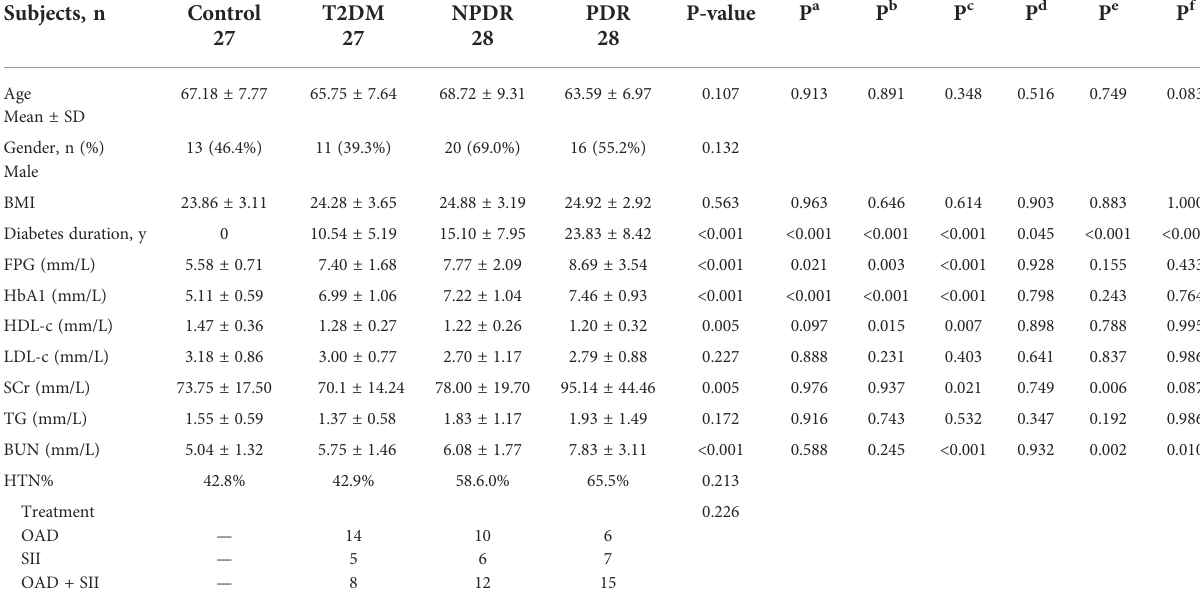
TABLE 1 Demographics, comorbidities and serum test results across groups. Subjects,